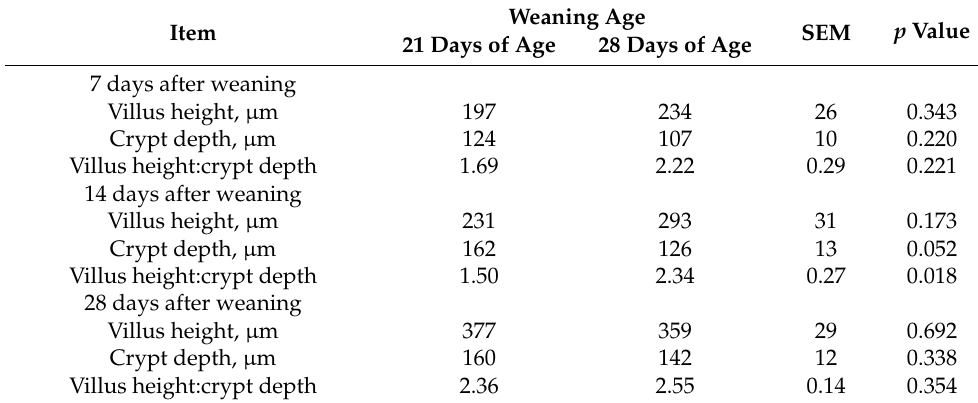
Table 5. Effect of weaning age on morphology of duodenum in weaned pigs 1 .